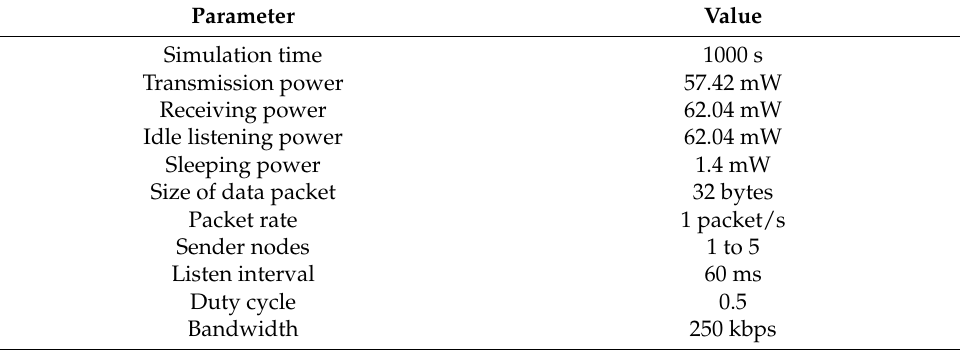
Table 1. Simulation parameters.